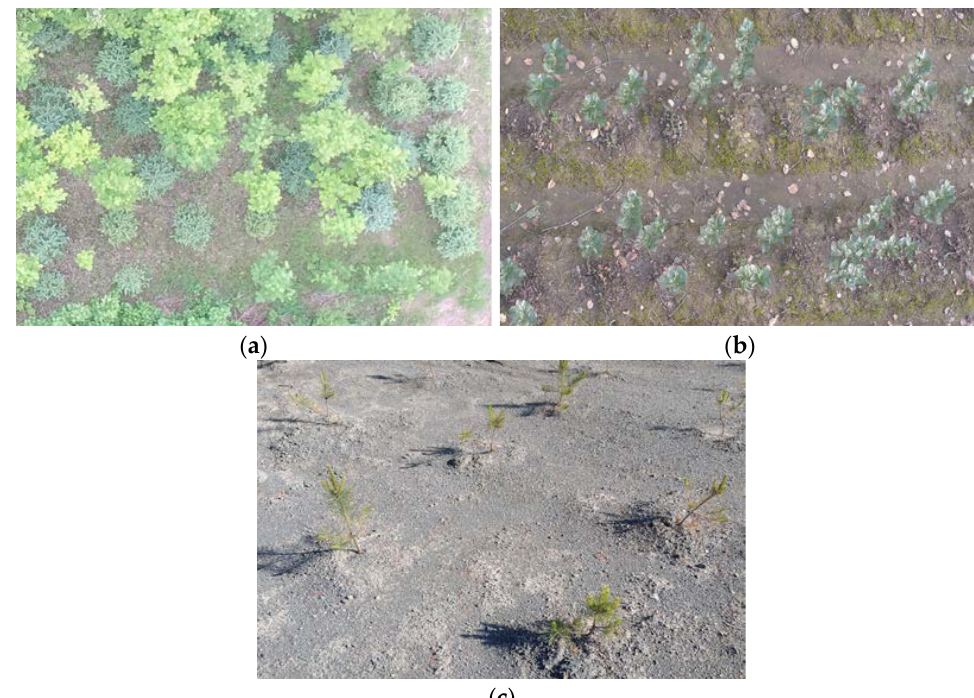
Figure 3. Images of the three types of seedlings after preprocessing, ( a ) dragon spruce, ( b ) black chokeberries, and ( c ) Scots